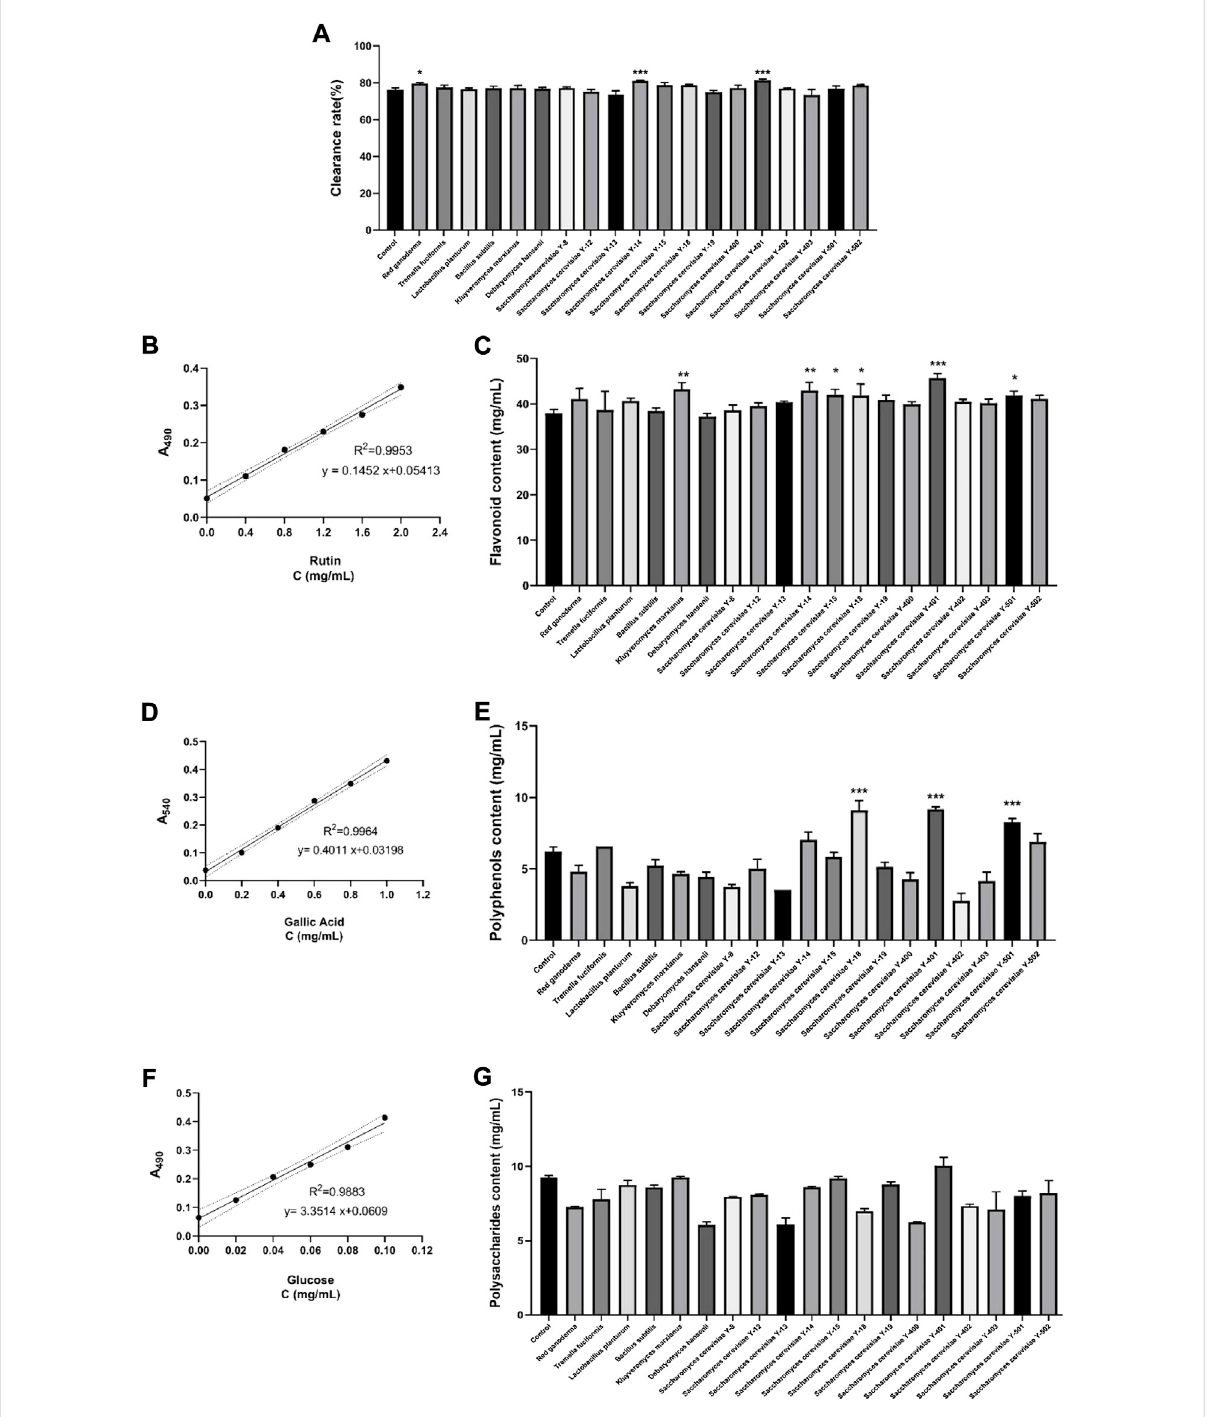
Screening most suitable strains for vine tea fermentation. (A) DPPH clearance rate, (B) Standard curve of rutin (within 95% CI) (C) Flavonoid content, (D) Standard curve of gallic acid (within 95% CI) (E) Polyphenol content, (F) standard curve of glucose (within 95%CI) (G)